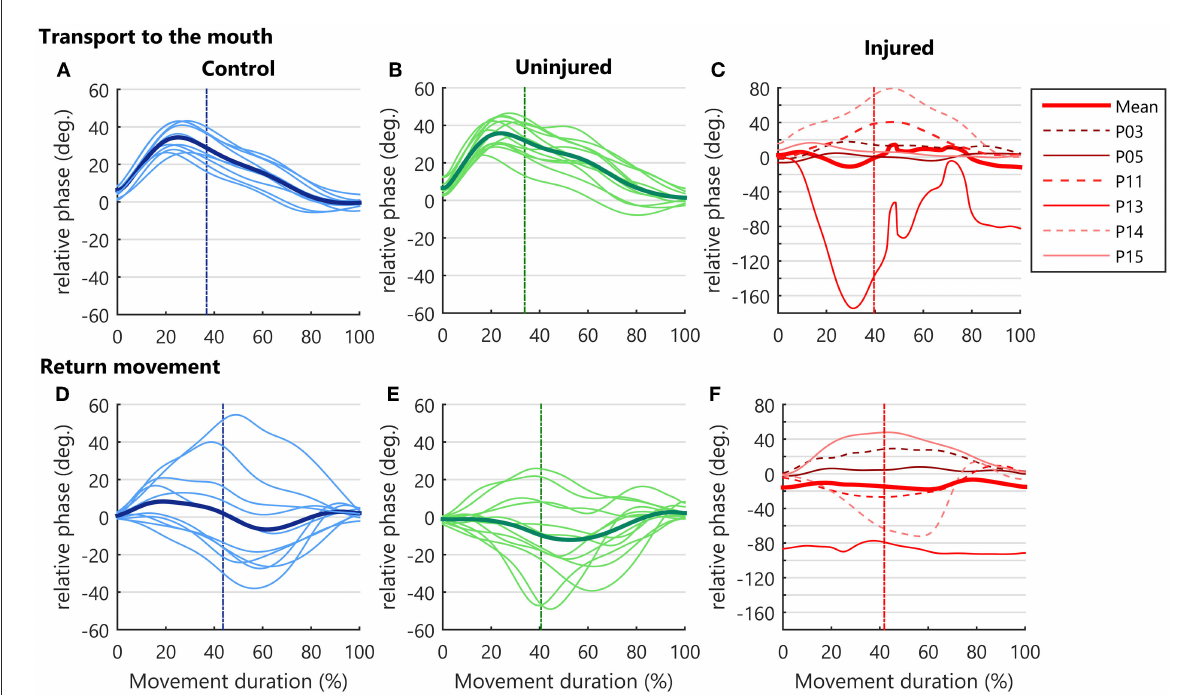
FIGURE4 Upper limb intersegmental coordination. RP curves during the bringing a cup to mouth cycle (transport and return) and are expressed as a function of the percent of movement phase duration. Solid thin lines correspond to the mean RP of each participant and the bold thick line corresponds to the mean performance of the group. The vertical dotted line indicates the moment when the hand achieves the peak velocity. As the injured upper limb exhibited a higher RP variability, a grid line was marked on the Y axis for every 20 degrees. (A–C) RP in hand transport to the mouth. (D–F) Relative phase in the return to starting